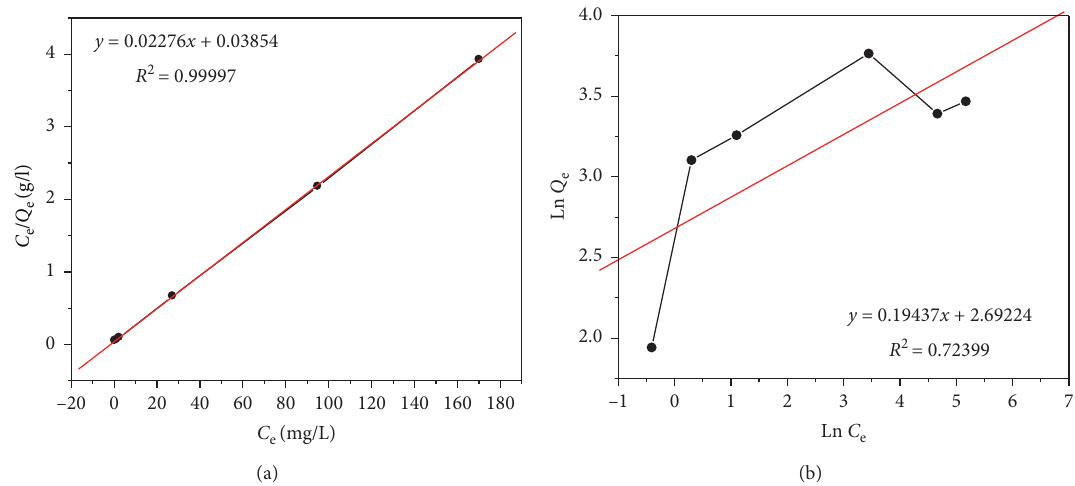
Figure 12: Adsorption isotherm curves of Cd 2+ follow the Langmuir (a) and Freundlich (b). y = 0.23033 + 0.01437 ∗ x R 2 = 0.99888